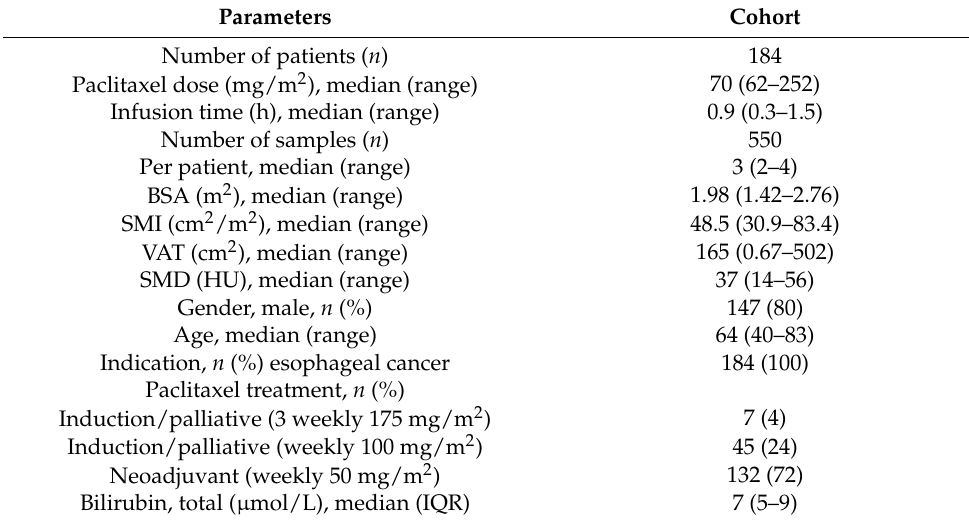
Table 1. Patient